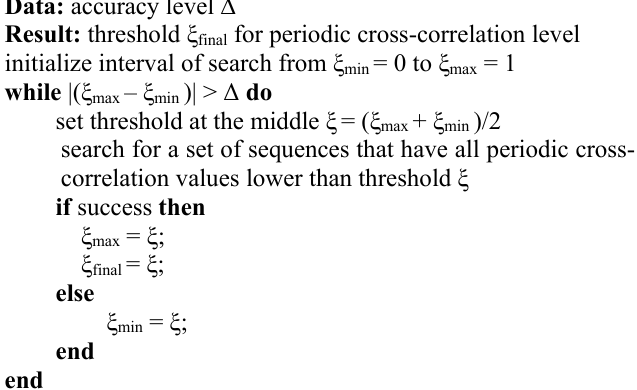
Algorithm 2. Algorithm of PCC threshold adaptation.